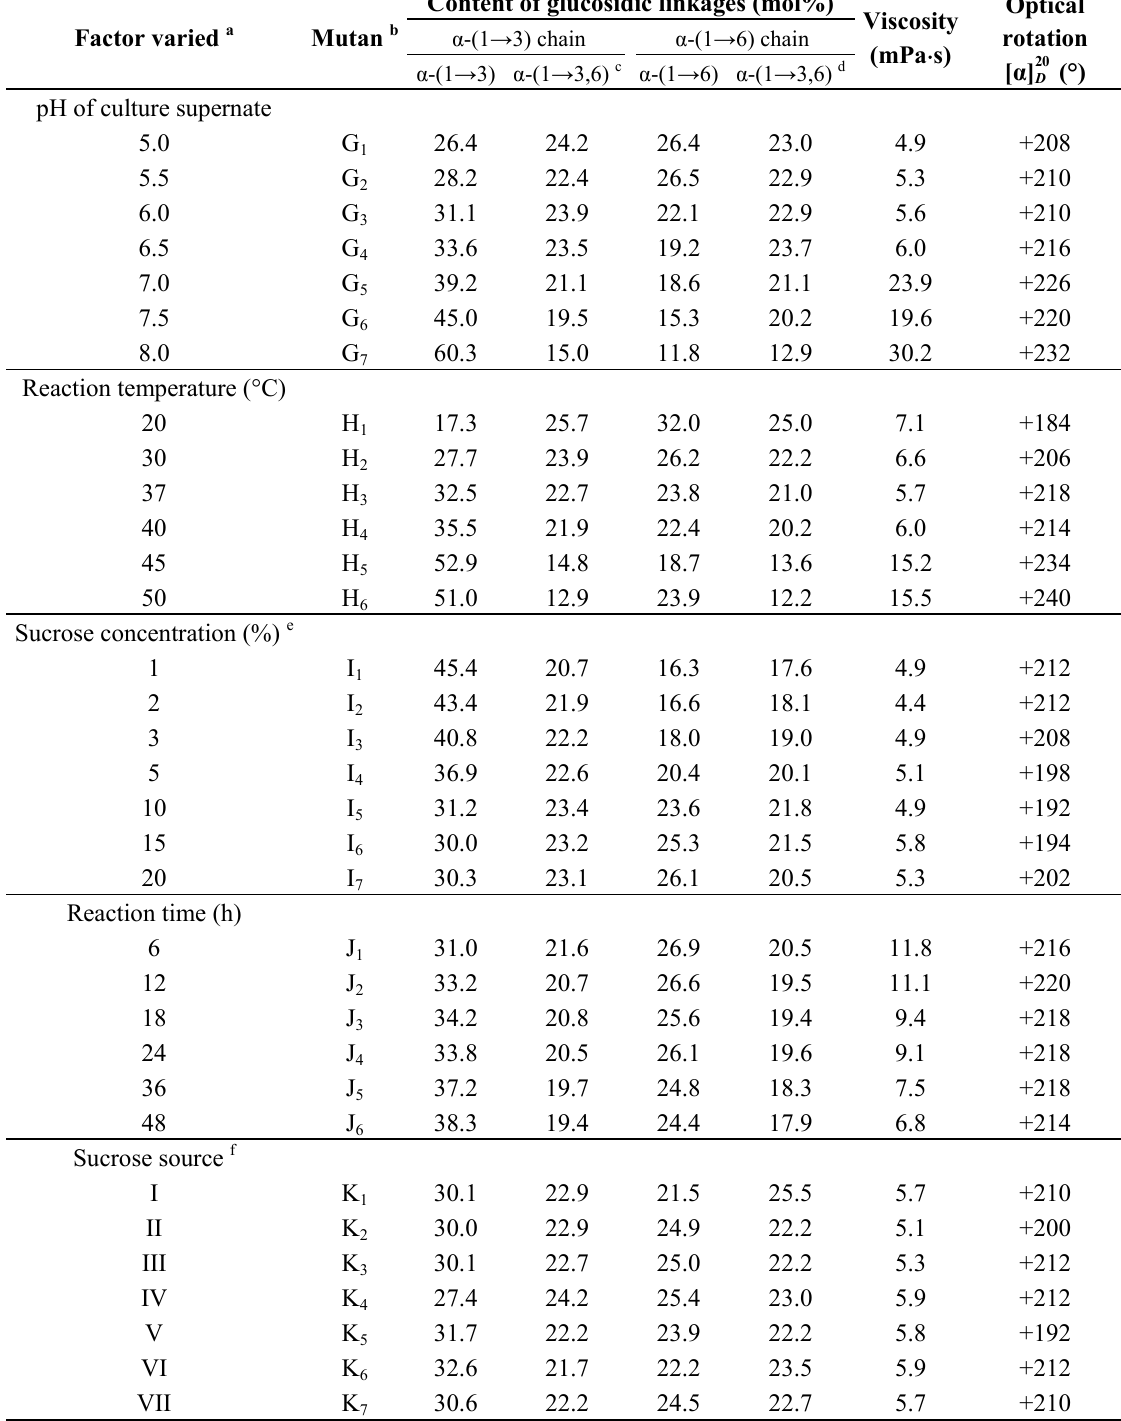
Table 3. Structure and some properties of mutans formed by streptococcal glucosyltransferases in post-culture supernates incubated under different environmental